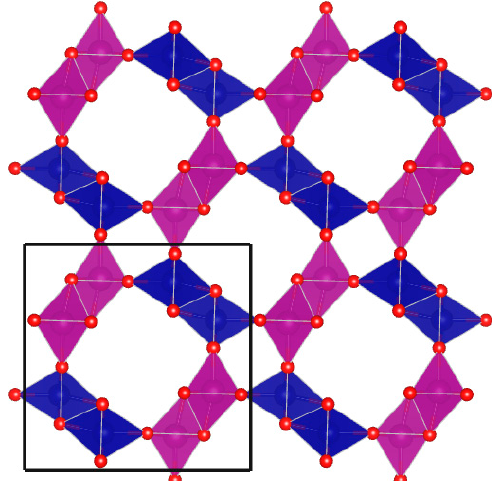
Figure 5. MnO 2 plane view perpendicular to the tetragonal axis. The unit cell used in the calculation is shown by the black borders. The oxygen atoms are red, and the purple/blue shade represents Mn octahedra with up/down spins in the antiferromagnetic order.